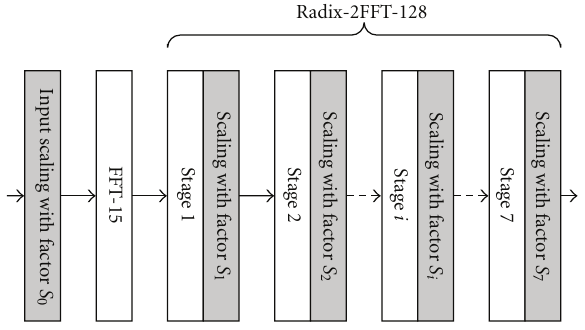
Figure 9: Positions in the FFT-1920 algorithm where scaling can be applied. Table 3: Implementation costs of FFTs used in